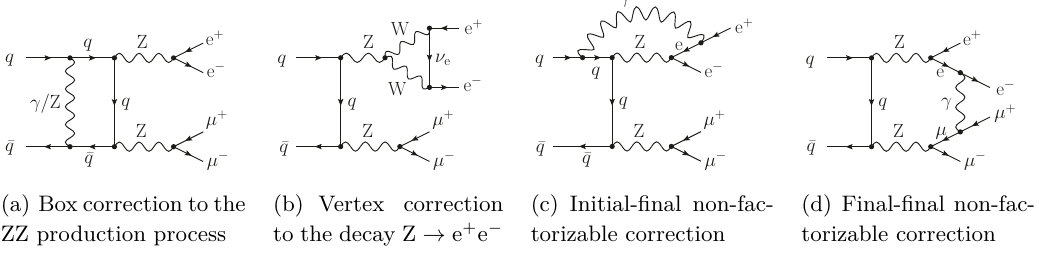
Figure 3 . Sample one-loop diagrams for four-charged-lepton production in the q ¯ q partonic channel at NLO EW.